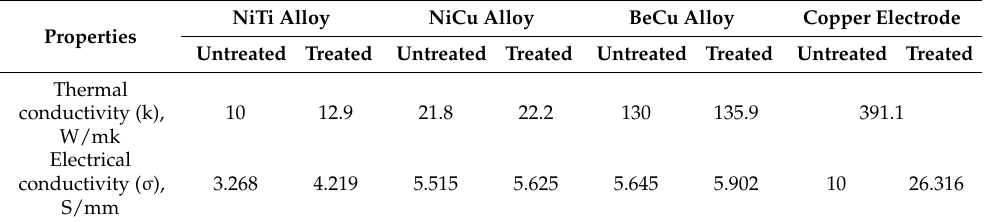
Table 1. Thermal and electrical conductivity of workpiece and tool.